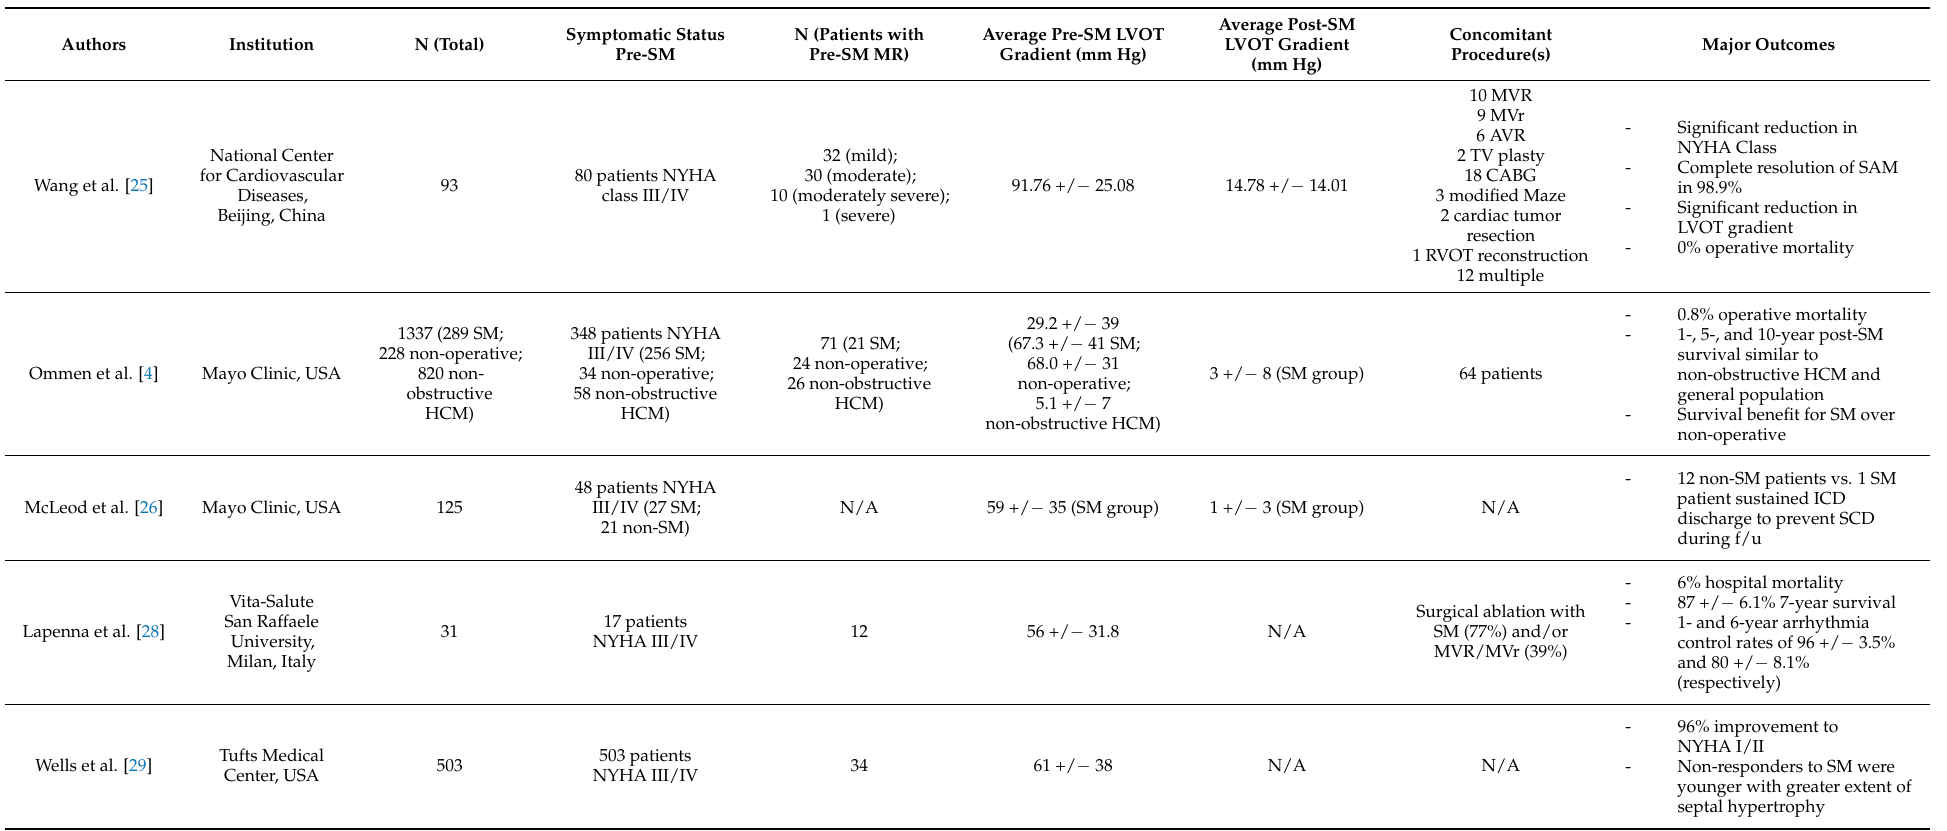
Table 2. Summary of the salient characteristics and results of studies on surgical myectomy for the treatment of hypertrophic obstructive cardiomyopathy discussed in this